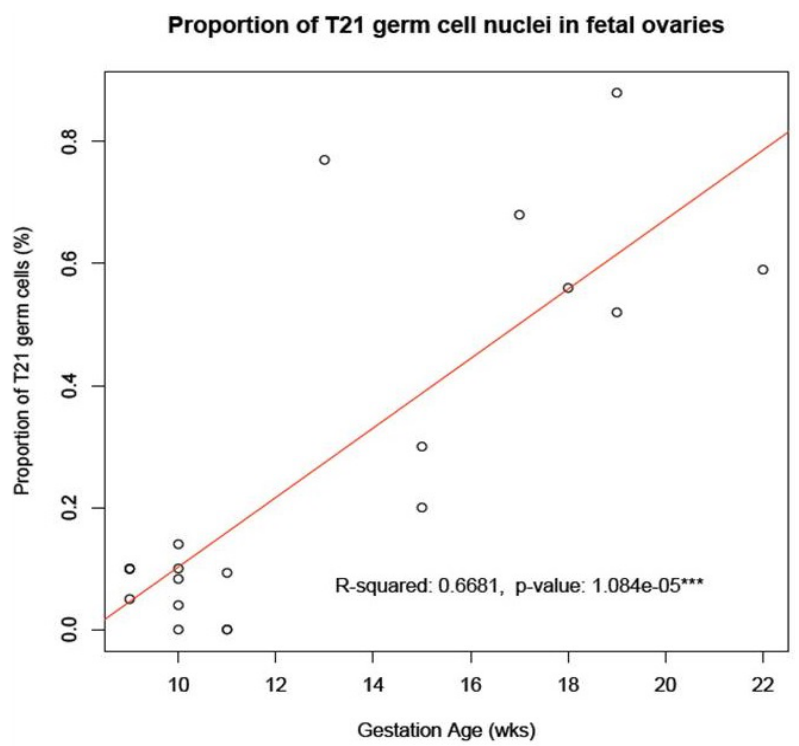
Figure 2. Accumulation of T21 oogonia/oocytes during fetal oogenesis. The graph shows the mean number of T21 oogonia/oocytes scored in samples of fetal ovaries during the first trimester (Table 1) in comparison to those during the second trimester (Table 1 in [6]). Note the apparent accumulation in incidence of T21 germ cells during the progression of oogenesis from the first to the second trimester of